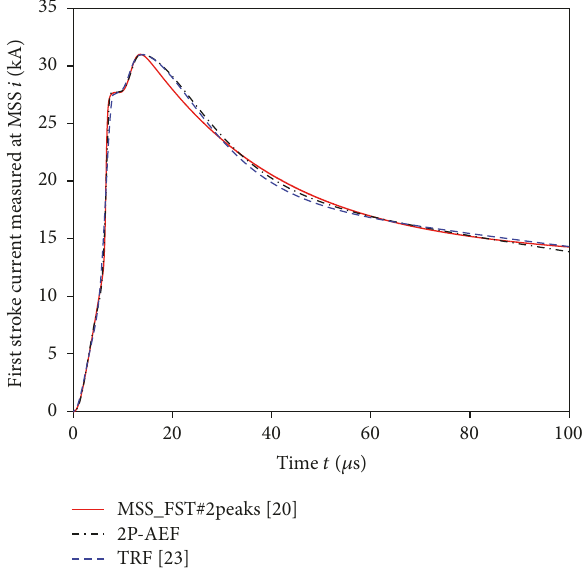
Figure 8: Measured current MCS FST#2peaks [20], TRF [23], and